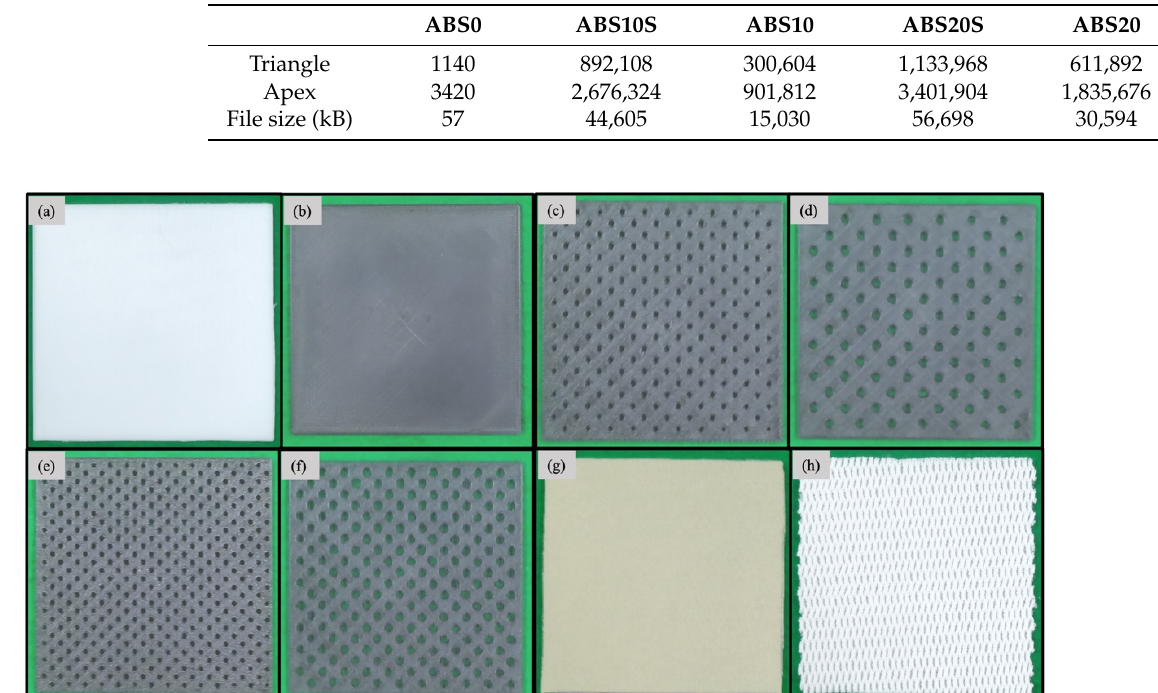
Figure 1. STL file view and that with frameworks of Specimens (100 × 100 mm 2 ) ( a ) ABS0 (STL file), ( b ) ABS0 (framework), ( c ) ABS10S (STL file), ( d ) ABS10S (framework), ( e ) ABS10 (STL file), ( f ) ABS10 (framework), ( g ) ABS20S (STL file), ( h ) ABS20S (framework), ( i ) ABS20 (STL file) and ( j ) ABS20 (framework). Table 1. The mesh model creation results for conversion to STL format of each specimen.